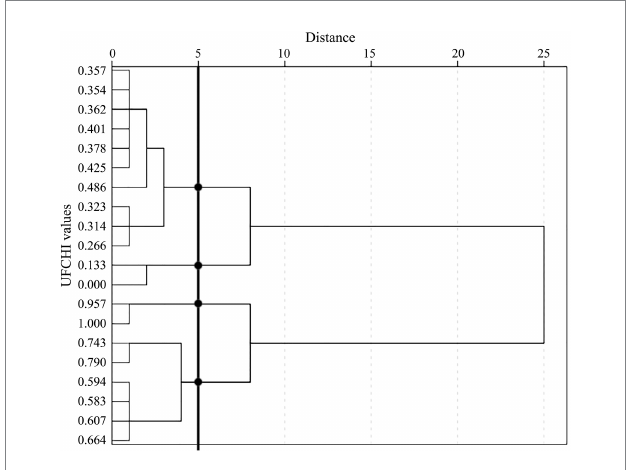
Figure 5. The annual average of AOC was in the order of exurban forest